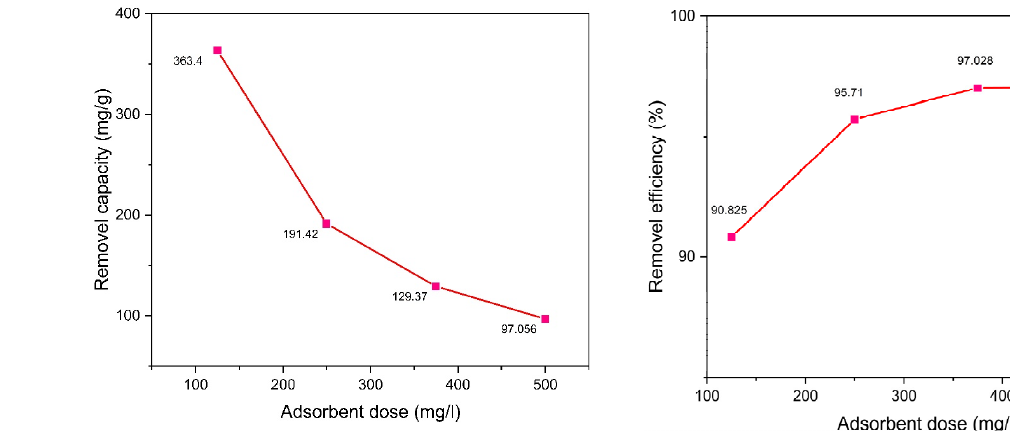
Fig. 11. Effect of adsorbent dose on the adsorption capacity of Pb (II) by nanoparticles.